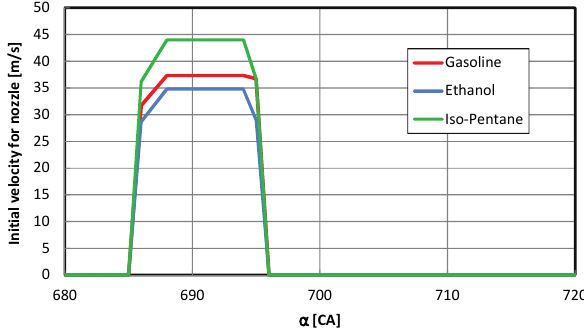
Fig. 9. The effect of the initial fuel droplet velocity during outflow from the injector on the fuel type during injection